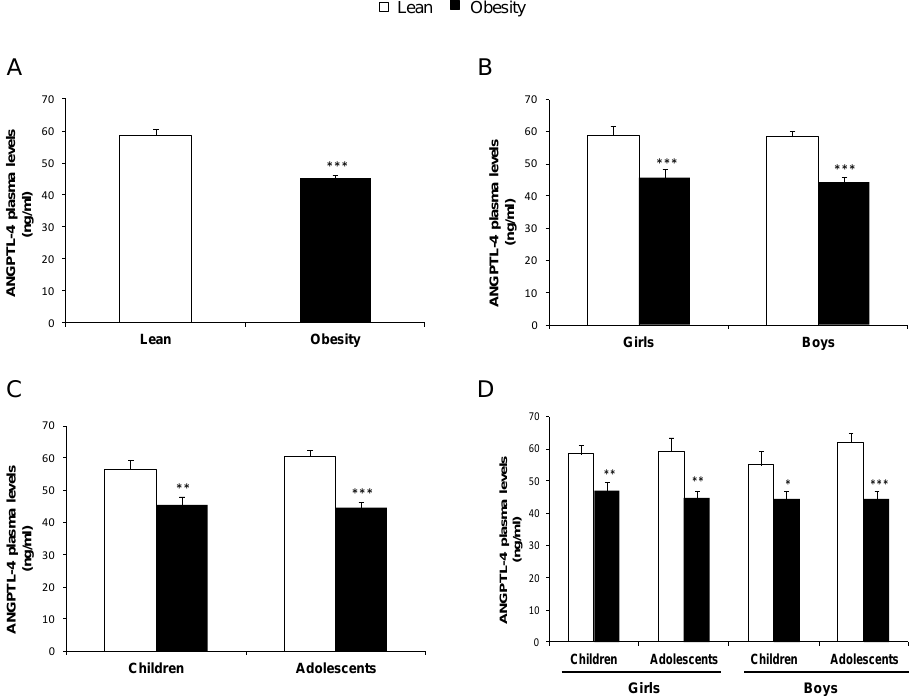
Figure 1. ANGPTL-4 circulating levels of the cross-sectional study population: ( A ) ANGPTL-4 concentration in individuals with normal weight and obesity; ( B ) ANGPTL-4 levels according to gender; ( C ) ANGPTL-4 concentration according to the pubertal stage; and ( D ) ANGPTL-4 levels according to gender and pubertal stage. Data are expressed as mean ± SEM. * p < 0.05, ** p < 0.01, *** p <